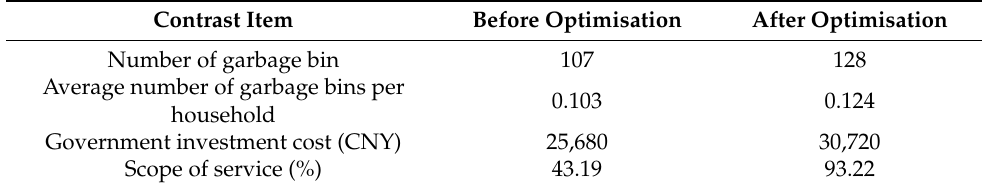
Table 2. Contrast items before and after optimising the layout of garbage